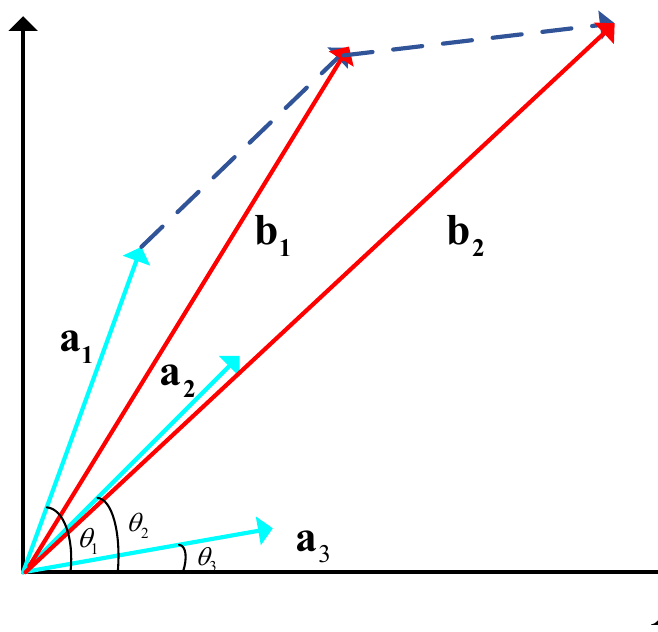
Figure 2. Diagram of multipath vector